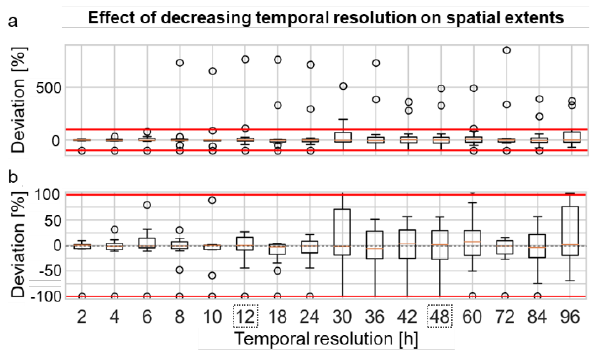
Figure 5. Deviation of spatial extent delineated by region growing for decreasing temporal resolution compared to the reference objects obtained at highest input data resolutions. (a) Full range of deviations, and (b) close-up to bounds of 100 %. Boxes on x-axis labels mark changes in the reduction interval.